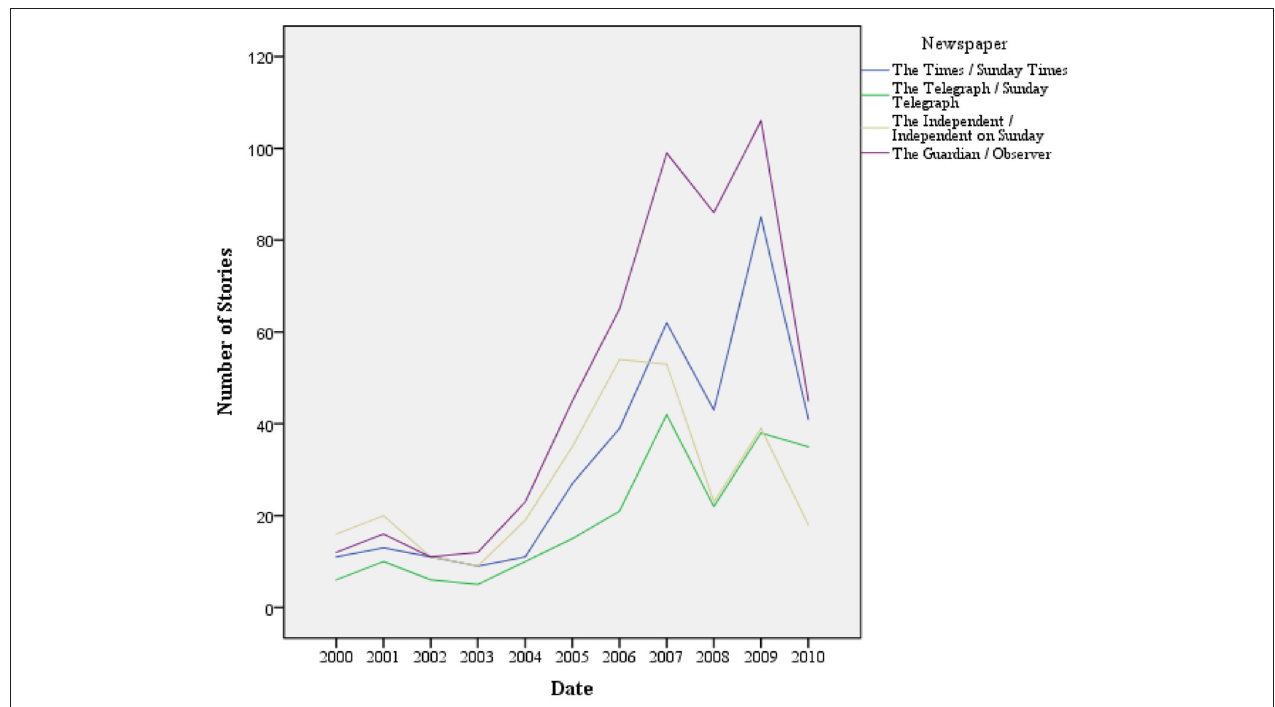
FIGURE 2 | Number of stories by newspaper by date.